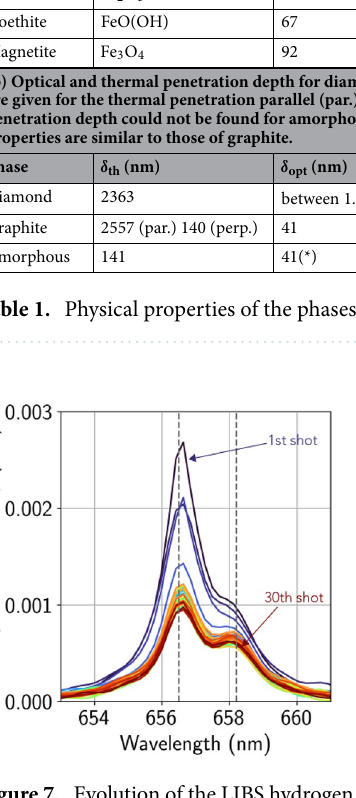
Figure 7. Evolution of the LIBS hydrogen line (656.6 nm) observed on goethite as a function of the number of shots, from blue (1st shot) to dark red (30th shot). The peak at ∼ 658 µ m is a carbon peak doublet from the breakdown of the CO 2 molecule of the atmosphere. Spectra are normalized to the mean intensity of the total